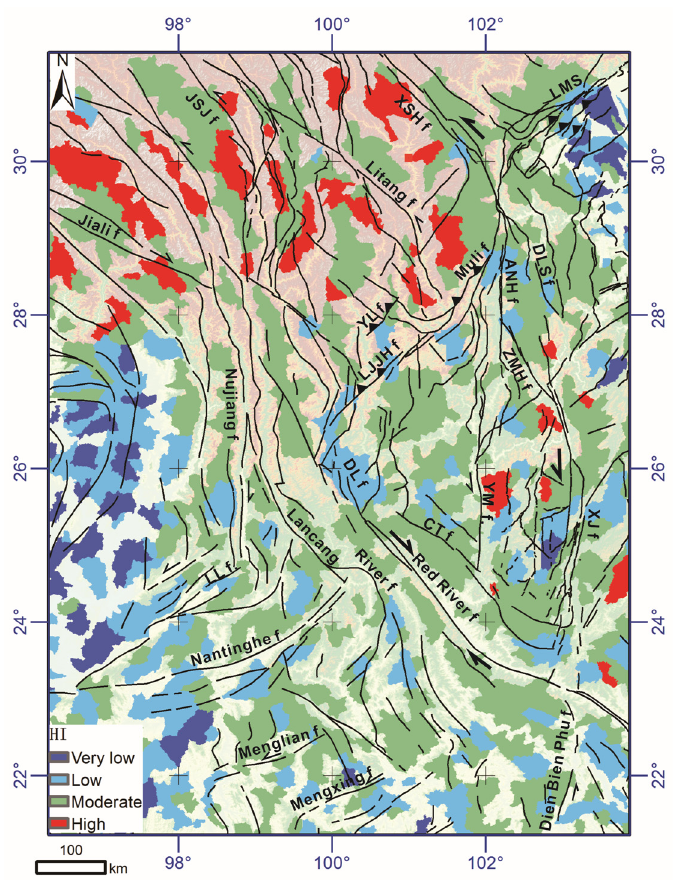
Figure 5. Spatial distribution of the hypsometric integrals of the eighth Strahler-order drainage basins. The catchment colors represent the following values: deep blue—very low (<0.2), light blue—low (0.2–0.4), green—moderate (0.4–0.6), and red—high (>0.6).